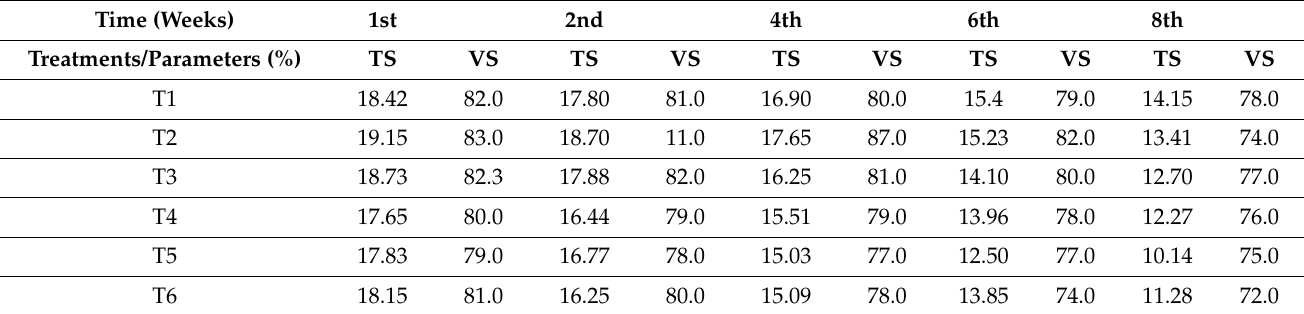
Figure 11. The effects of different treatments of IONPs on organic carbon content during anaerobic. digestion of cattle manure. Bars with different letters depict significantly different values at p ≤ 0.05. Table 2. Effect of different treatments of IONPs on total solids and volatile solid degradation during eight weeks of batch digestion.